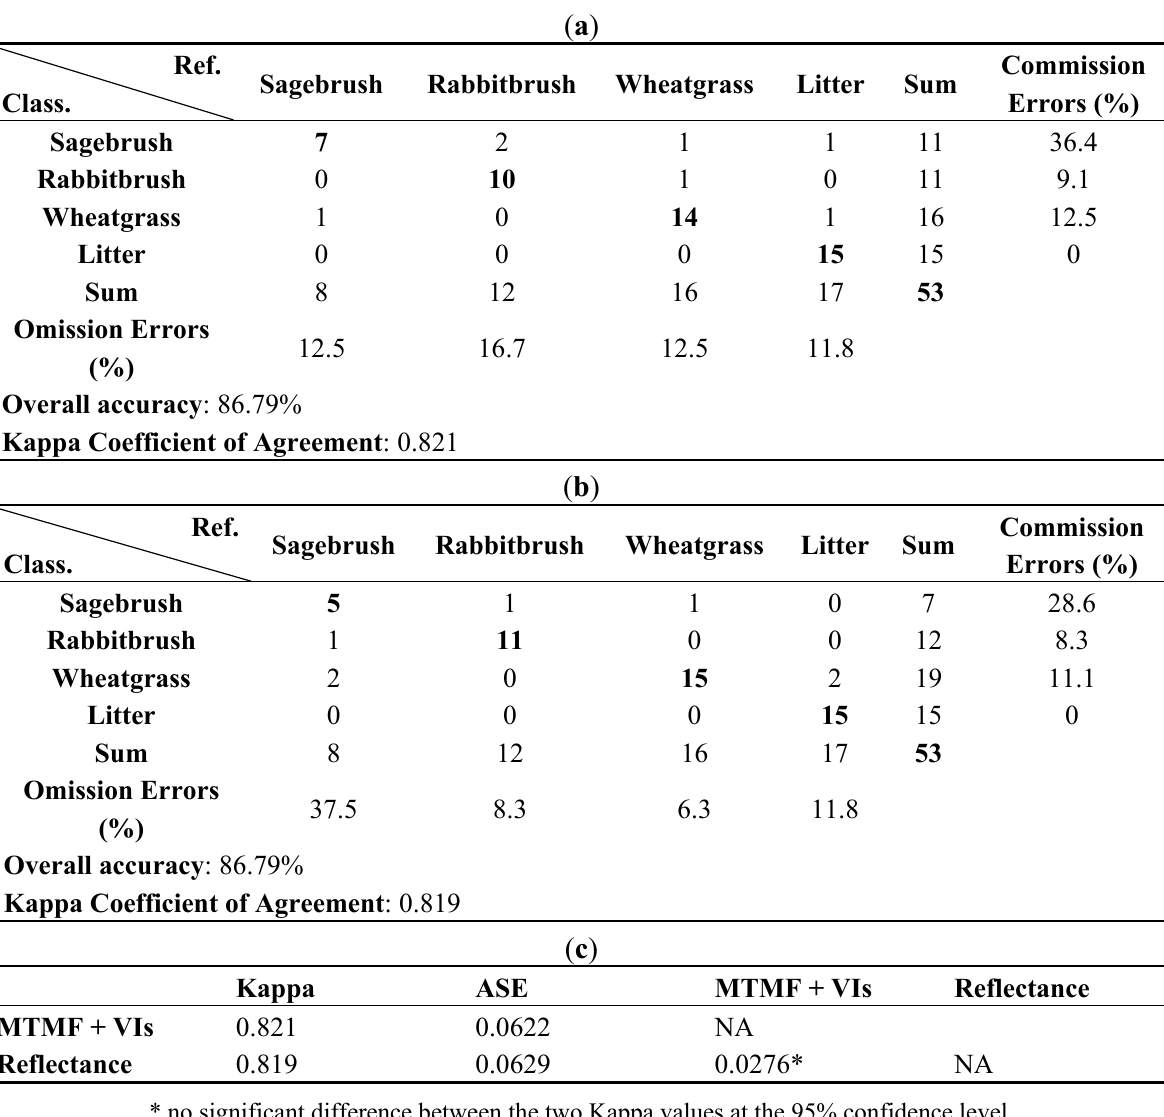
Table 5. Accuracy assessment results of the decision tree classifications for the Monticello site: ( a ) using the MTMF variables and vegetation indices, ( b ) using the scaled reflectance data, and ( c ) Kappa Z-test between the two